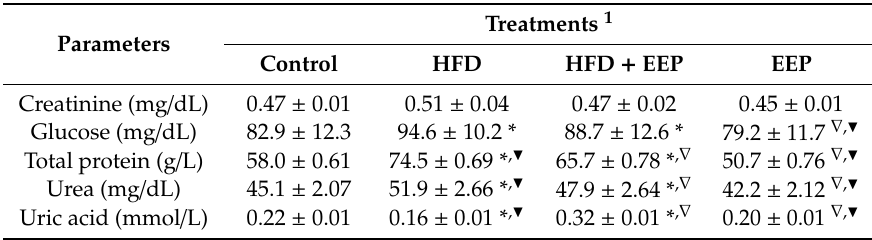
Table 5. E ff ect of ethanol extract of propolis on biochemical parameters in serum in high-fat diet fed